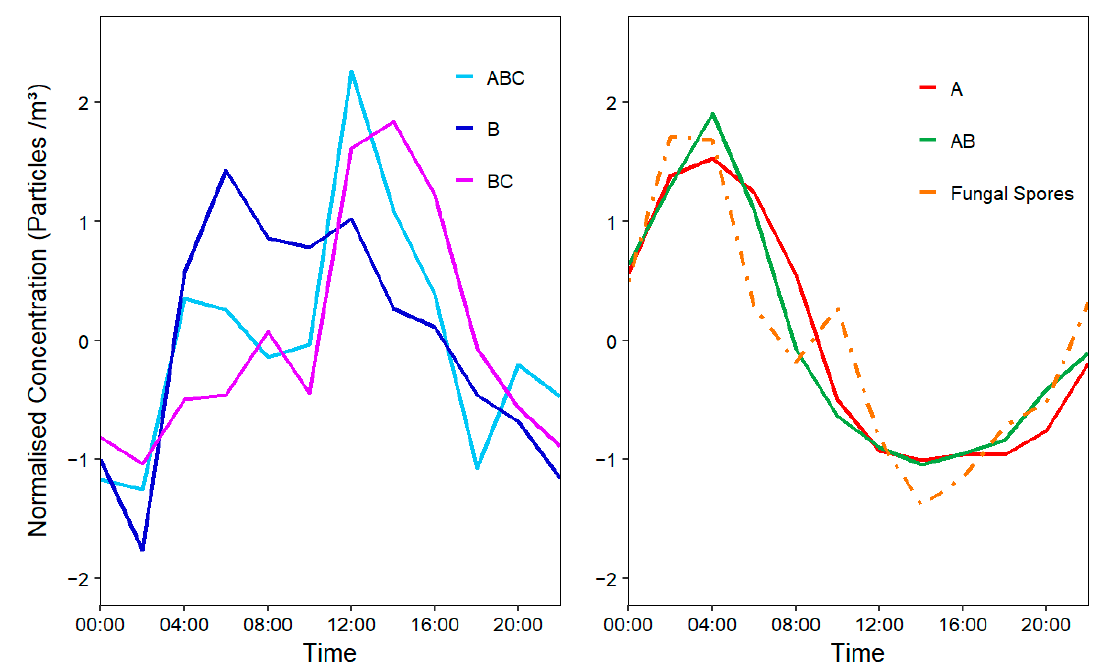
Figure 5. Normalised Diurnal (local time) fungal spore concentrations sampled via the Lanzoni compared to isolated WIBS particle concentrations.